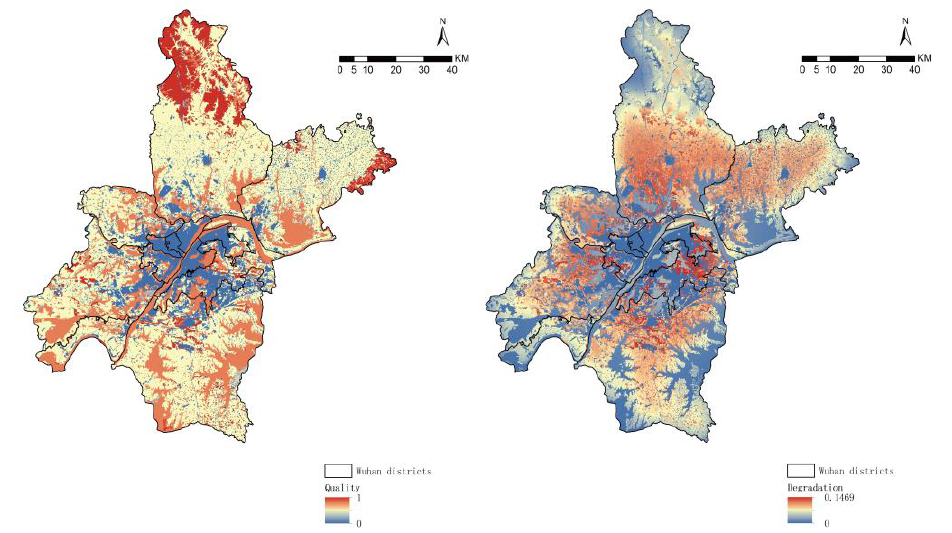
Figure 3. Maps of habitat quality and habitat degradation.